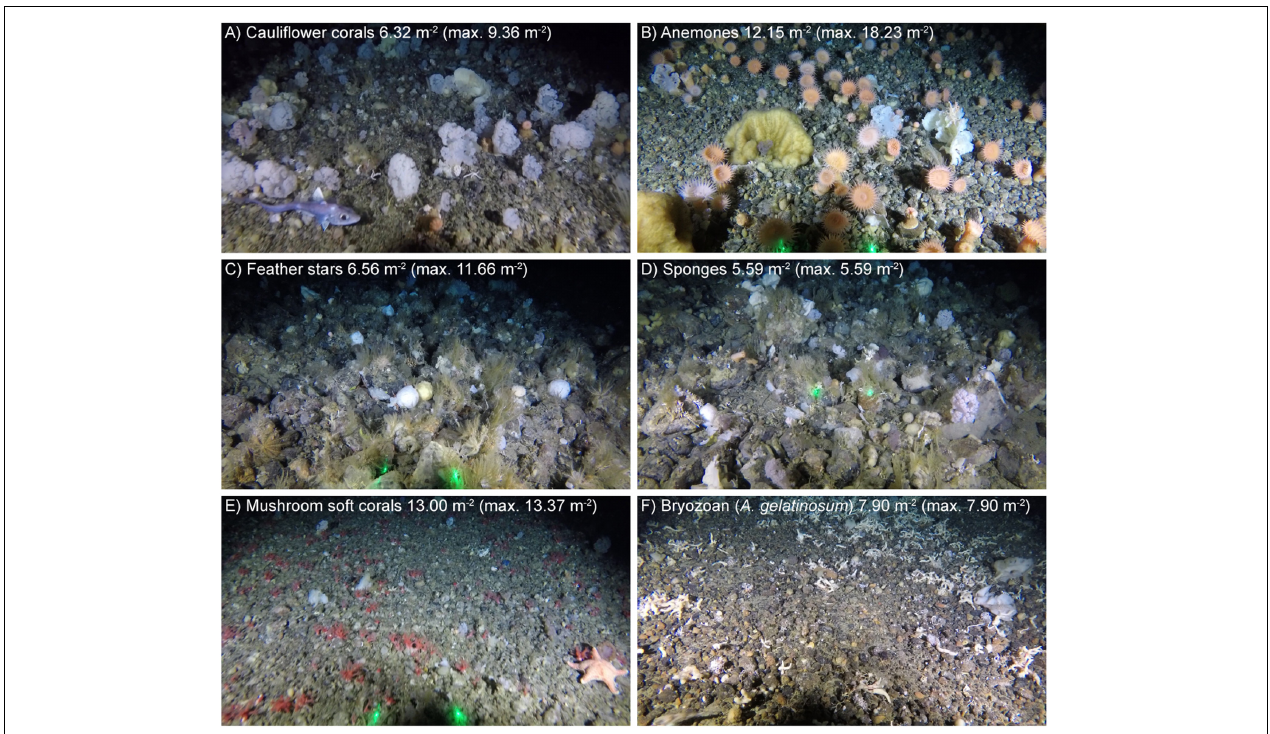
FIGURE 4 | Examples of different assemblages with high density of: (A) Cauliflower corals; (B) Anemones; (C) Feather stars; (D) Sponges; (E) Mushroom soft corals; and (F) Bryozoan ( A. gelatinosum ). Images were selected for illustrative clarity. The density of the highlighted taxa within each image is reported (along with the maximum observed density in all images for reference). Where present, laser dots (green) are 20 cm